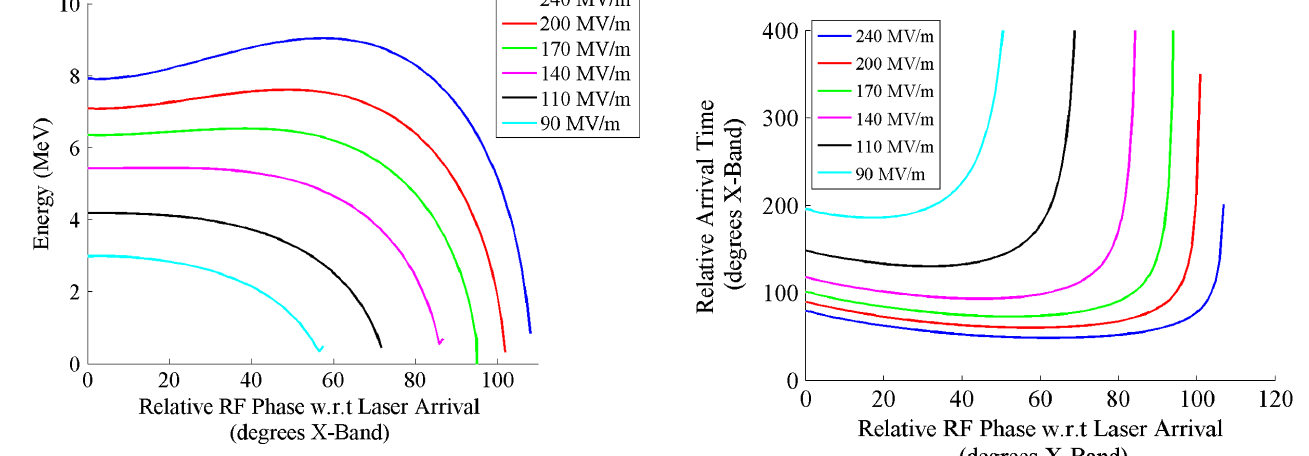
FIG. 13. Calculated single electron energy from the X-band gun versus the cathode rf phase at the laser arrival time for various cathode gradients. Zero phase corresponds to the rf zero-crossing.